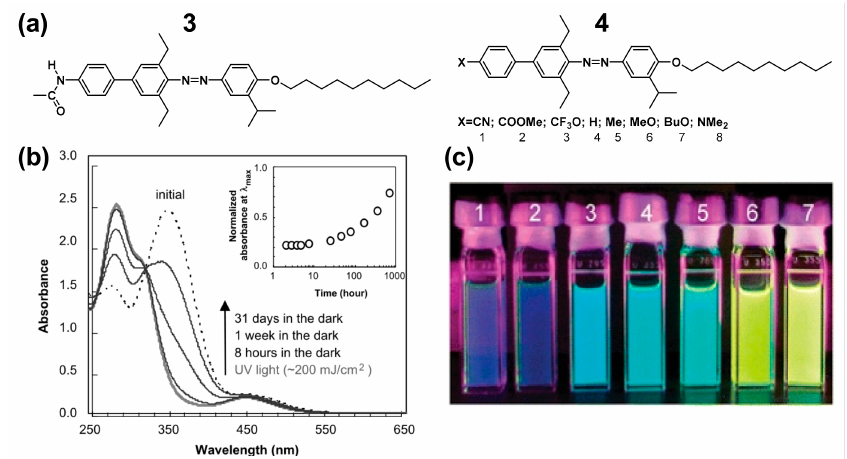
Figure 4. ( a ) The molecule structures of a series of steric hindrance azobenzene derivatives 3 , 4 . ( b ) Changes in UV-vis absorption spectral changes of azobenzene ( 3 ) solution (8 × 10 − 5 M). After